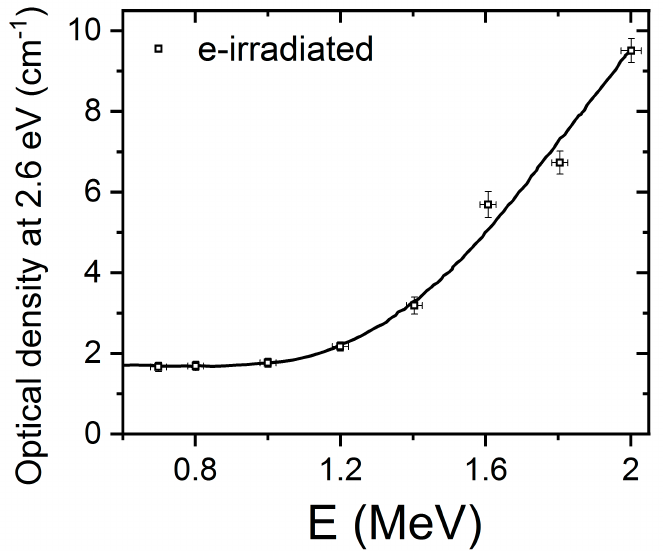
Figure 3. Normalized height of the optical absorption band at 2.6 eV as a function of the electron beam energy for congruent LiNbO 3 . This figure has been adapted from Hodgson et al. [32], Copyright (1987), with permission from Elsevier.